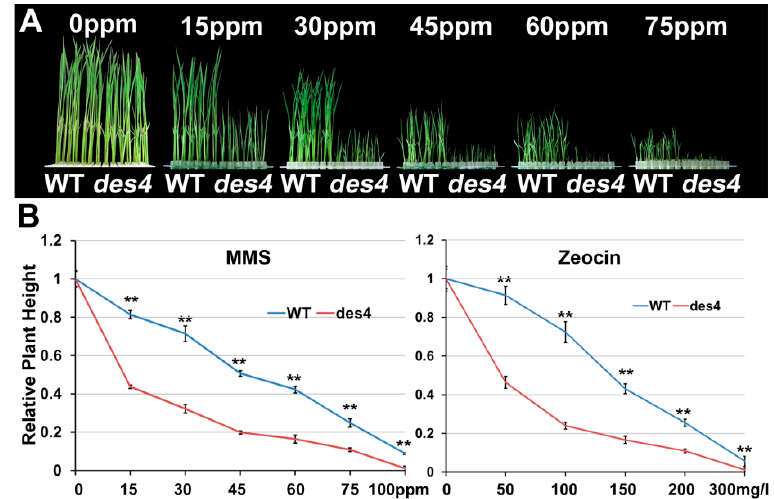
Figure 4. Genotoxic stresses on des4 and WT seedlings. ( A ) Growth of des4 and WT seedlings under different methyl methanesulfonate (MMS) concentrations. ( B ) Quantification of the seedling heights under different concentrations of MMS and zeocin. ** p < 0.01.